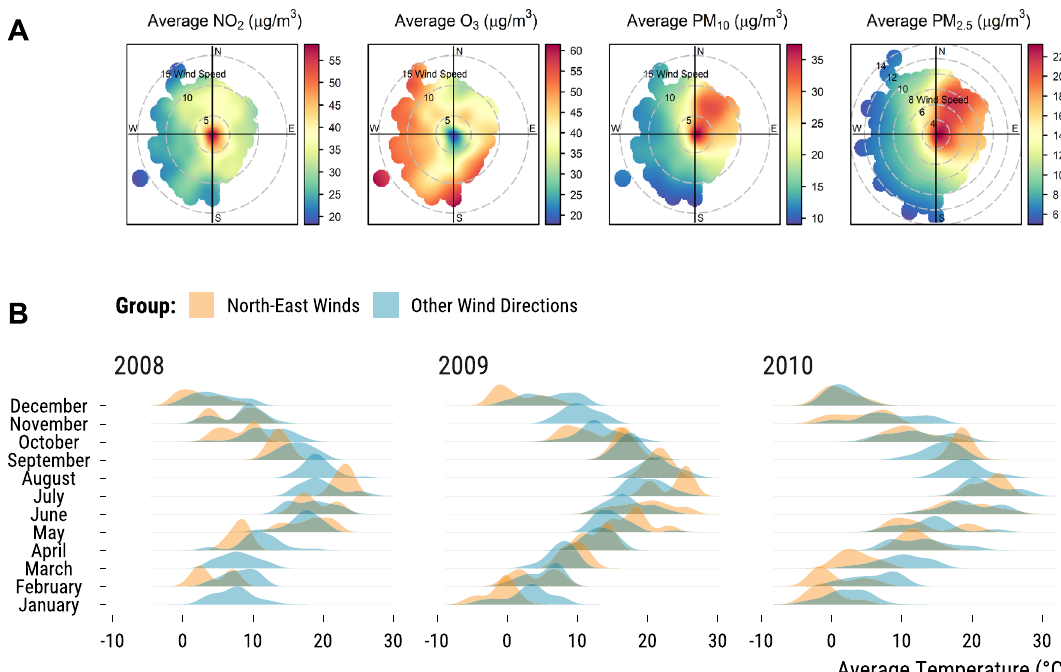
Figure 1. Polar plots of air pollutant concentrations predicted by wind components and average temperature imbalance of wind directions by year and month. In panel ( A ), each plot represents the concentrations (in µ g / m 3 ) of an air pollutant that were predicted using a generalized additive model based on a smooth isotropic function of the two wind components u and v 15 . The direction from which the wind blows is described on a ◦ 360 compass rose and wind speed (in m/s) is represented by a series of increasing circles starting from the intersection of the two cardinal directions axes where wind speed is null: the farther the circle is away from the intersection, the faster the wind speed is. In panel ( B ), the density distribution of the average temperature ◦ (in C) is drawn for North-East winds (orange colour) and other wind directions (blue colour). The figure is divided into subplots by month and year